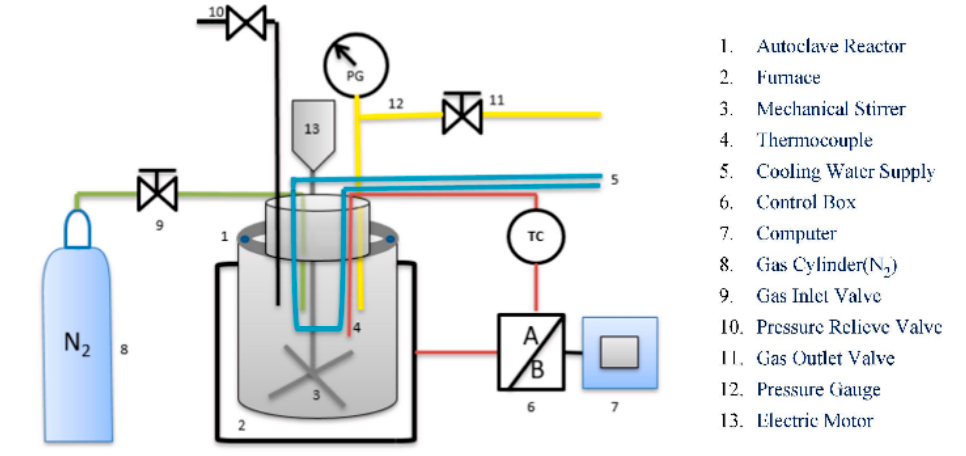
Figure 6. Process flow diagram of HTL process of lignocellulose biomass (Adapted from Gollakota et al. [67] ).